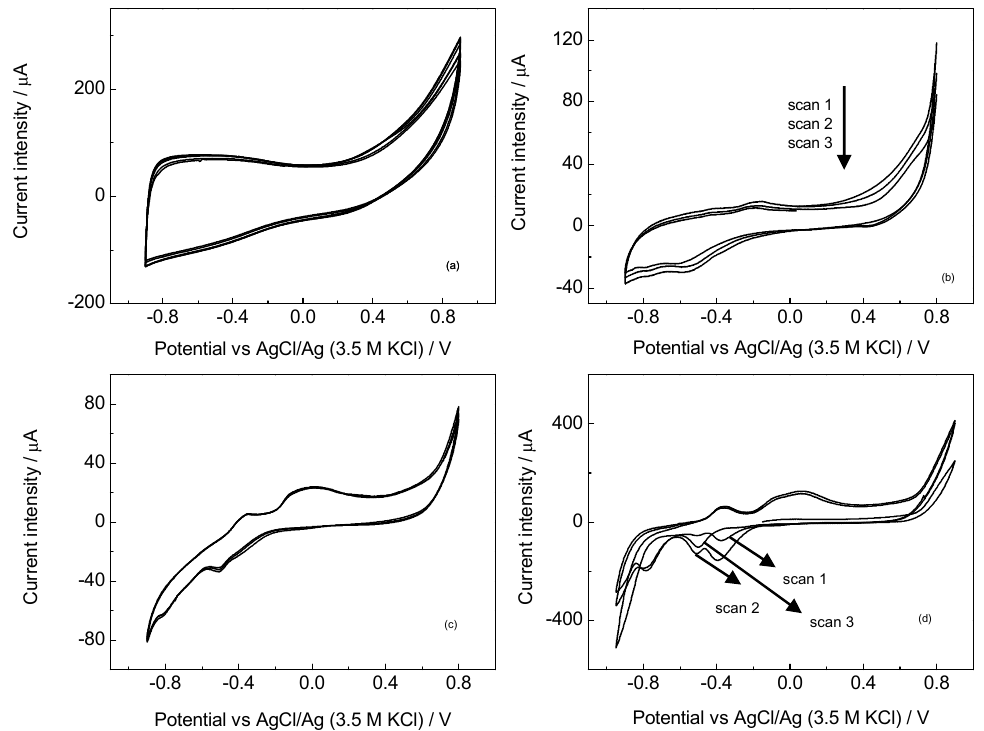
Figure 2. Cyclic voltammograms of the electrochemical response of ( a ) Nafion/S, ( b ) Nafion/SCu, ( c ) Nafion/CMCu, and ( d ) Nafion/CMCuGr in 0.1 M NaOH. 40 wt.% Nafion ionomer in the catalytic inks. Scan rate 10 mV s − 1 . Three scans recorded.